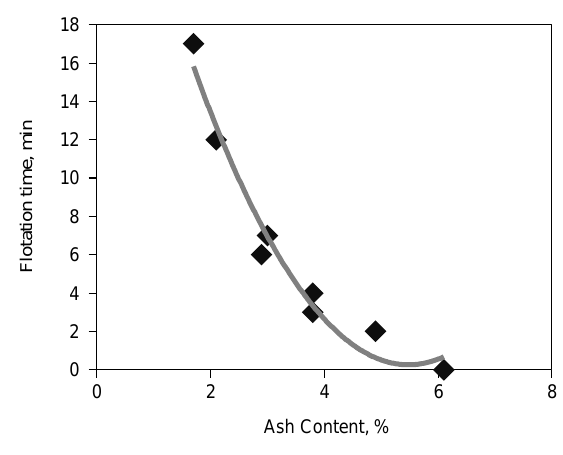
Fig. 2 Effect of flotation time on ash content of de-inked pulp (0.5% H